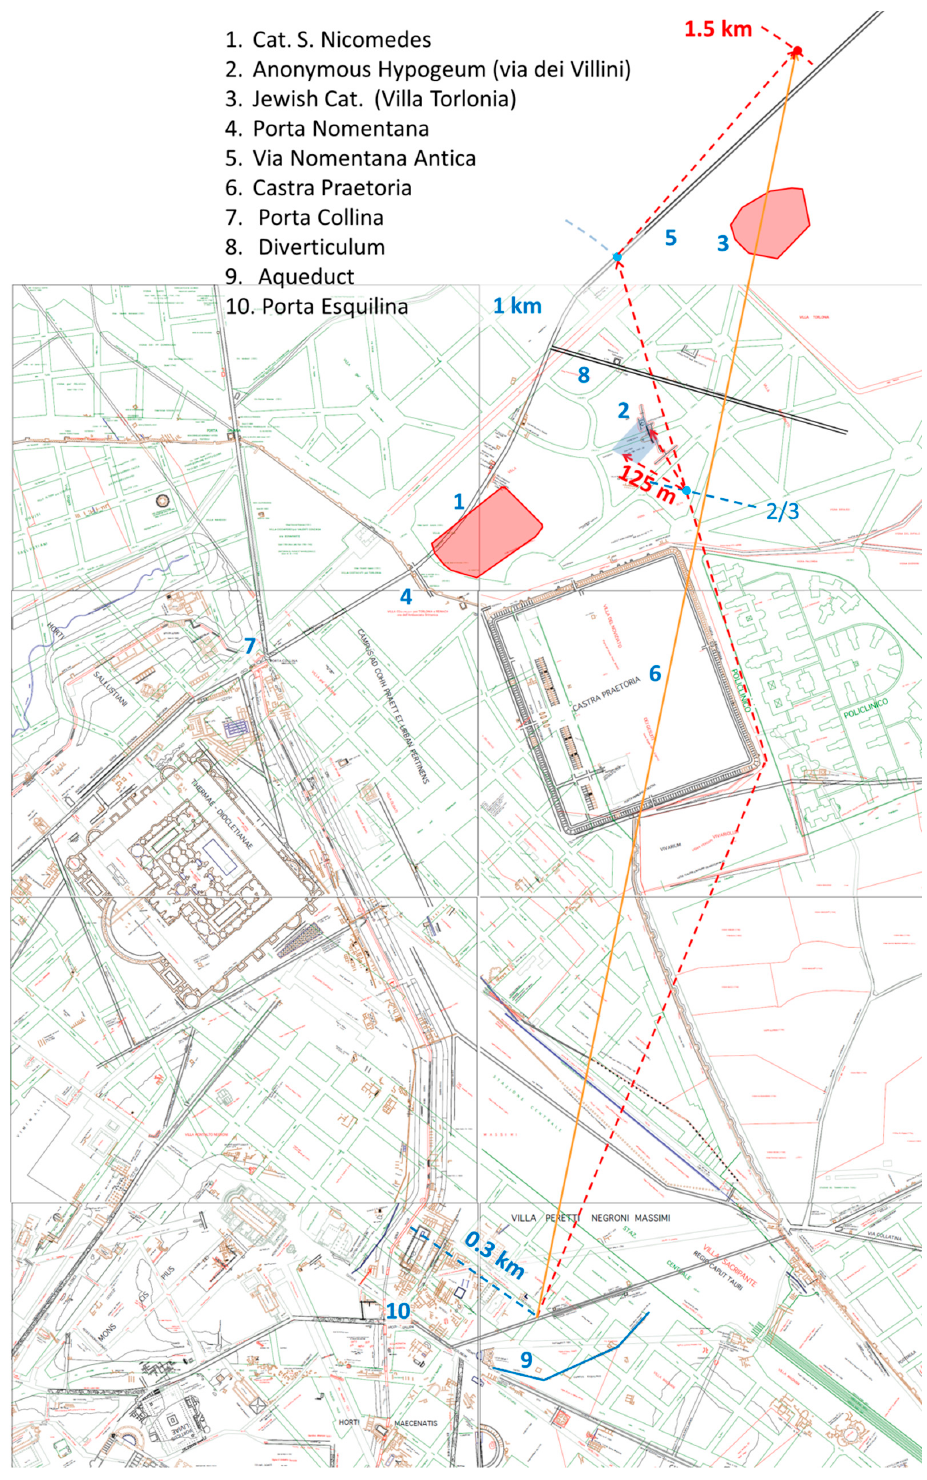
Figure 7. Map of Rome drawn by Lanciani [54] showing the main archeological remains between Via Tiburtina and Via Nomentana. The red–dotted lines sketch Peter’s path. The path of the ancient Via Nomentana is in black. The areas in red represent the catacombs. The region highlighted in blue is where Peter’s first burial site should be, according to the topographic elements provided by Maria Valtorta.